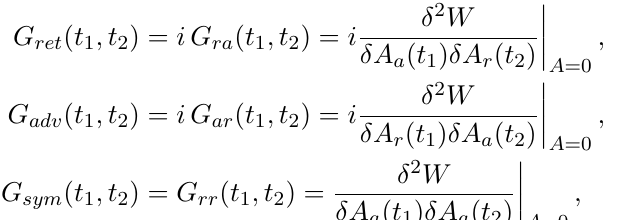
Figure 1 . The Schwinger-Keldysh contour at (cid:12)nite temperature. Time (cid:13)ows forward from t = 0 to t = + and back to where the initial state is de(cid:12)ned. The latter is represented by an imaginary 1 time segment identi(cid:12)ed along the circles with period (cid:12) = 1 =T . functional W = i ln Z as (cid:0)